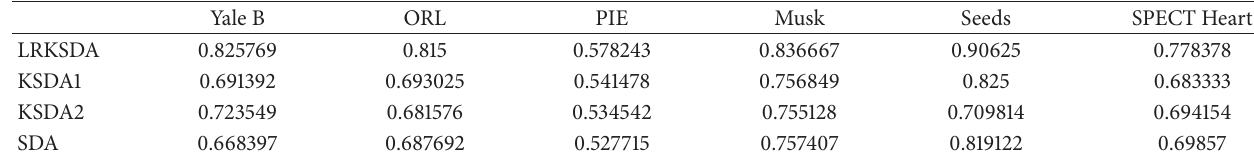
Table 1: Classification accuracy of different SDA algorithms on six databases.